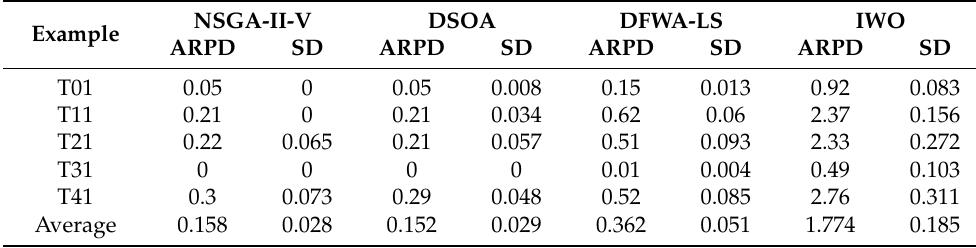
Table 4. Comparison of the results of the